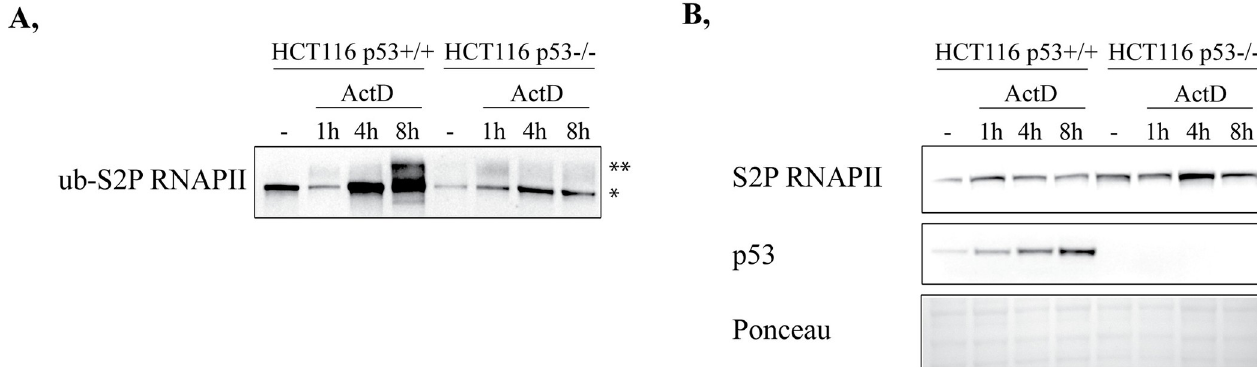
Fig 3. p53 is essential for preventing the premature ubiquitylation of RNAPII following ActD treatment. ( A ) Tandem ubiquitin-binding entities (TUBEs) pull-down, followed by Western blot detection was performed in HCT116 p53+/+ and p53-/- cells. TUBEs experiment was accomplished under basal conditions as well as 1 h, 4 h, and 8 h following ActD. From the pulled-down ubiquitylated protein pool, polyubiquitylated S2P RNAPII (ub-S2P RNAPII) was detected with anti-S2P RNAPII antibody. � : monoubiquitylated S2P RNAPII, �� : polyubiquitylated S2P RNAPII. ( B ) Western blot experiment on whole cell lysates of HCT116 p53+/+ and p53-/-, which were used for TUBEs pull-down assay. Total protein level changes of S2P RNAPII and p53 following 1 h, 4 h, and 8 h ActD treatments in HCT116 cells were immunodetected using specific antibodies. Ponceau staining was applied to detect the equal loading of the input